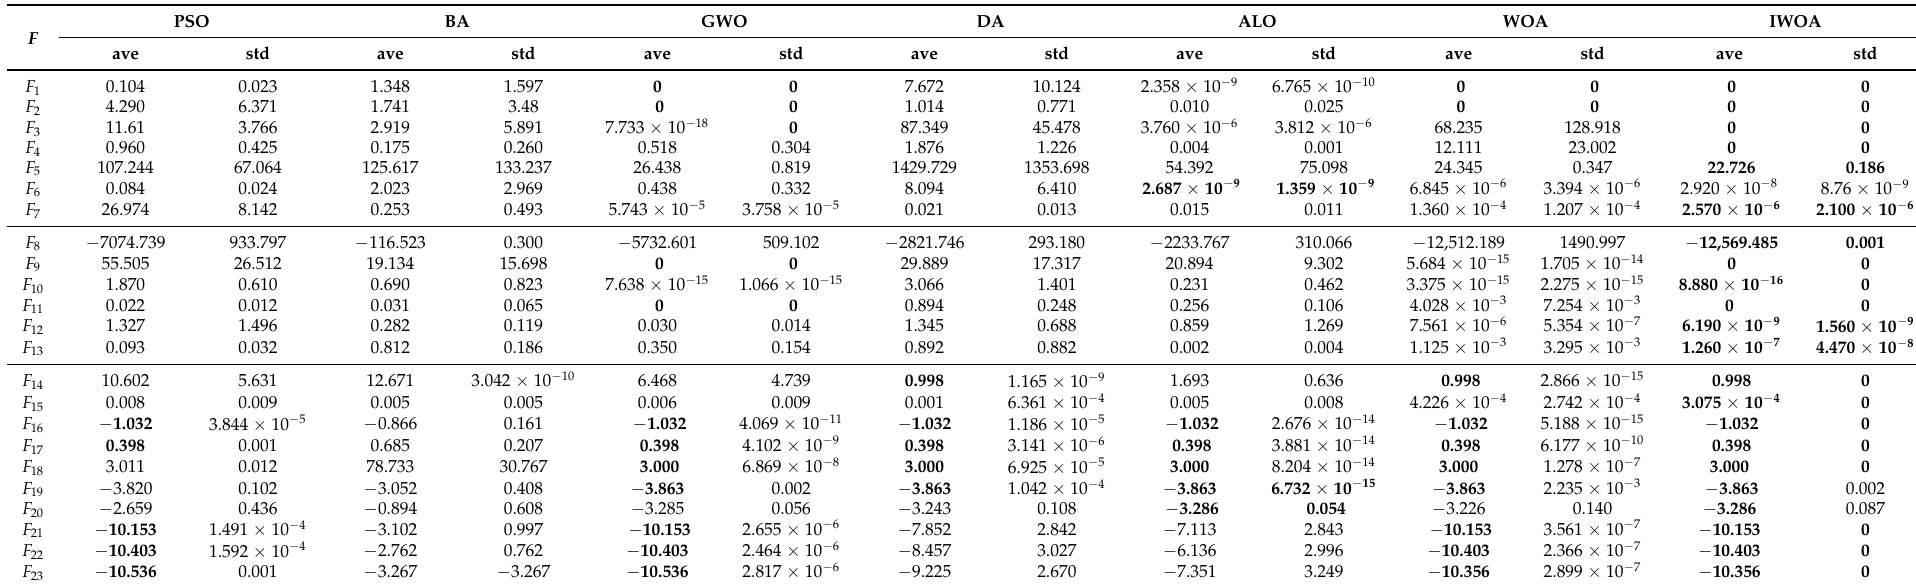
Bold in the table represents the best result compared to different algorithms when solving